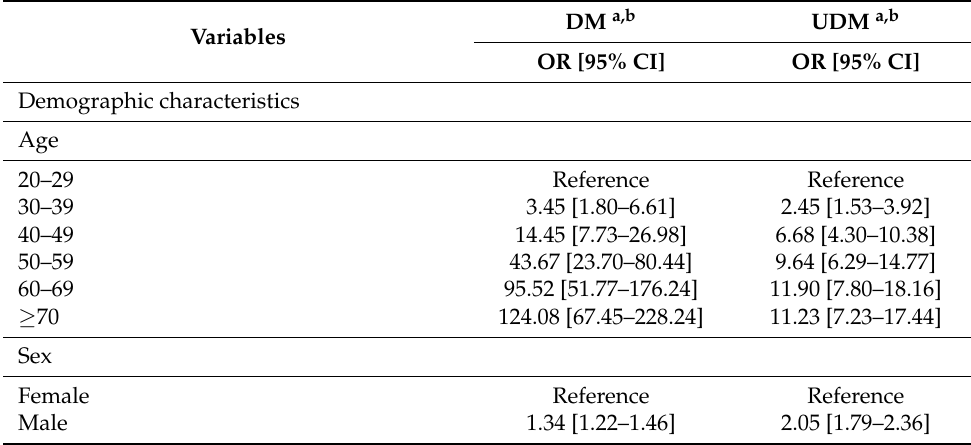
Figure 2. Forest plot of the association between baseline risk factors and DM/UDM status. The analysis was performed using an age- and sex-adjusted multinomial logistic regression model. The without-DM group was used as the reference. The ORs and 95% confidence intervals are drawn on the graph; dark-colored points with lines indicate DM and gray-colored points with lines indicate UDM. ORs with 95% CIs in bold style indicate a p -value of <0.05. DM, diabetes mellitus; UDM, undiagnosed diabetes mellitus; AOR, adjusted odds ratio. Table 2. Results of the analysis investigating the crude association between baseline risk factors and DM/UDM status using multinomial logistic regression models. The without-DM group was used as the